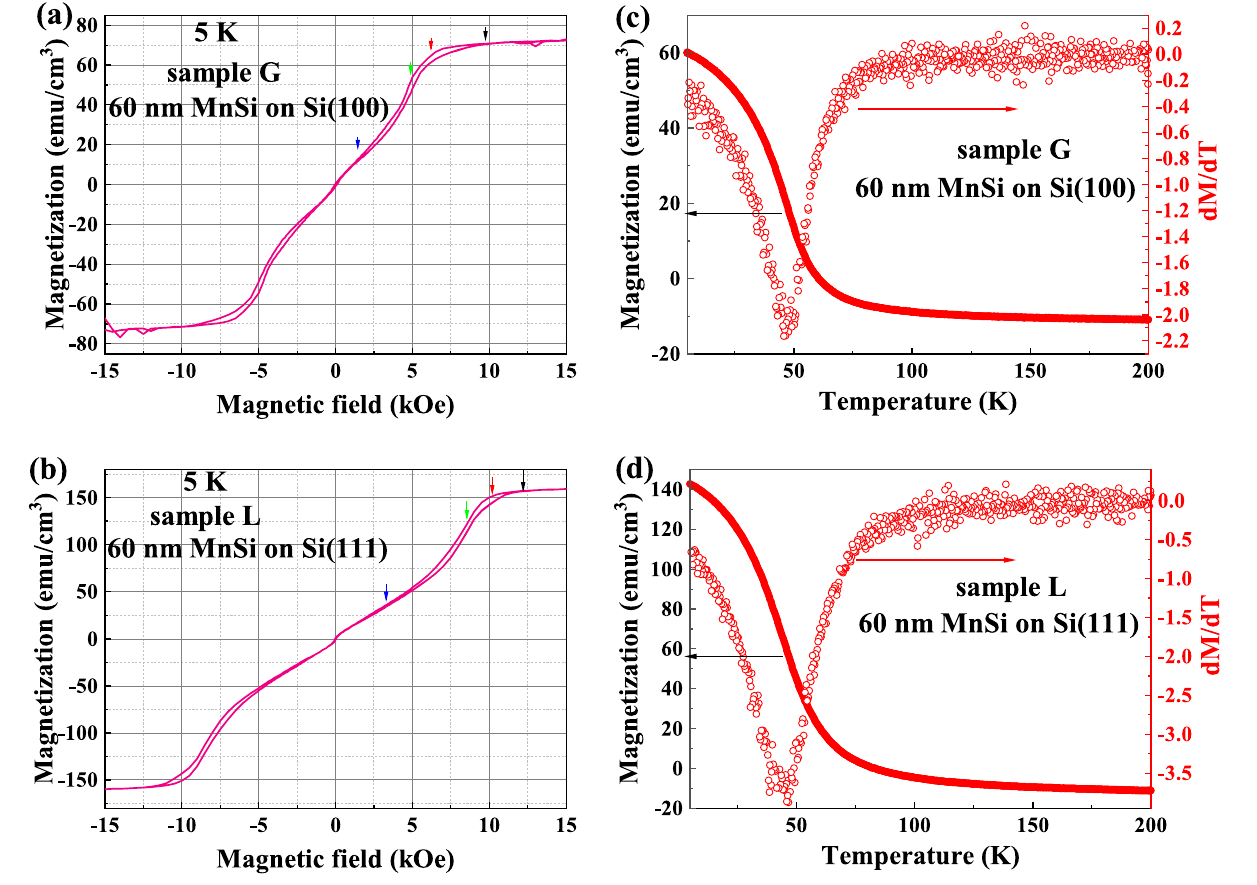
Figure 2. In-plane MH curves recorded at 5 K for samples G and L with a 60 nm MnSi films on ( a ) Si(100) substrates and ( b ) on Si(111) substrates, respectively. The easy axis and multi-hysteresis are stabilized in-plane. The arrows obtained from the peaks of the differential MH curves indicate the fields where the magnetic phase transition occurs. Temperature-dependent in-plane saturation magnetization (solid symbol) and the calculated dM/dT (open symbol) for samples G ( c ) and L ( d ). The valley of dM/dT indicates the Curie between different peaks, the MnSi phase in this sample is highly (111) textured. Within the detection limit, there is no visible peak, which can be assigned to the MnSi 1.7 . From our measurements for other samples with different thickness (not shown), we have found the following: (1) MnSi films on Si(100) are always polycrystalline with the co-existence of the MnSi 1.7 s phase; (2) MnSi films on Si(111) are highly (111) textured and we can obtain either pure MnSi phase or the mixture of two phases with different concentration ratios. As shown exemplarily in Fig. 2a and b for samples G and L with 60 nm MnSi films grown on Si(100) and (111) substrates, the in-plane magnetic loops at 5 K show a multi-hysteresis feature that occurs only when the magnetic states change, which is similar to the results reported for other MnSi films 27 or bulk 21 . It is consistent with the magnetic helicoidal states at low temperature as suggested by Wilson et al. 28 . Later, magnetic skrymions were found at higher temperatures by the same research group 29 . The saturation magnetization for sample G is around 75 emu/cm 3 , which is lower than the value for bulk B20 MnSi due to the co-existence of MnSi 1.7 para- sitic phase. The saturation field for this sample is around 9 kOe. However, the single-phase sample L in Fig. 2b shows a higher saturation magnetization of 165 emu/cm 3 , which is close to that for bulk MnSi. This sample also has a higher saturation field of 13 kOe. The mixture with MnSi 1.7 does not affect this multi-hysteresis behavior. However, there is a clear difference in the critical fields (obtained from the peaks of the differential MH curves) labelled by arrows in the figure. This hints towards different magnetic anisotropy in the films on Si(100) and (111) substrates. The fully skyrmions are stabilized in the range between green and red arrows. The Curie temperature of magnetic materials can be measured by different methods, such as temperature dependent magnetization, resistance or heat capacity 30–32 . From the magnetization, it can be determined by the temperature-dependent remanence 33 and by calculating dM/dT for the temperature-dependent magnetization 12 . T C can also be determined by measuring the temperature-dependent resistance. In such a case the first derivative dR/dT shows a peak around the critical temperature 34 . At the same time, the temperature-dependent magnetore- sistance also shows a peak around T C 35 . Figure 2c and d show the in-plane magnetization of samples G and L as a function of temperature under a magnetic field of 15 kOe, which is above the saturation field. The calculated dM/dT curves are shown as open symbols. The minimum of the curves is found at the same temperature for films on Si(100) and (111) substrates, which is defined as the Curie temperature. We also estimated the T C from